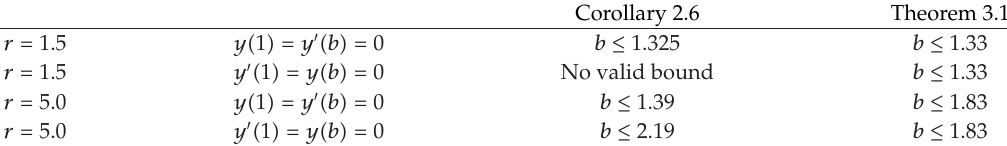
Table 4: Comparison of upper bounds for b in Example